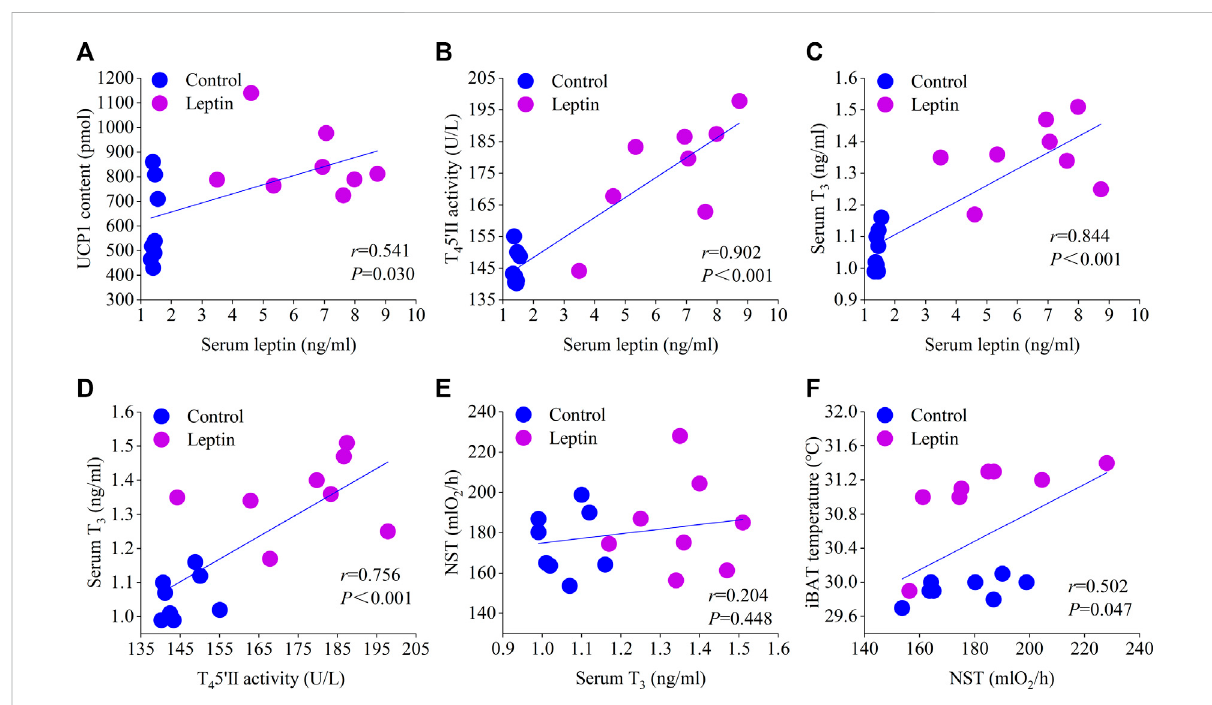
FIGURE 6 Correlation of serum leptin with UCP content (A) , T 4 5 ′ -DII activity (B) , and T 3 content (C) ; correlation of serum T 3 with T 4 5 ′ -DII activity (D) and NST (E) ; correlation of NST with interscapular skin temperature (F) .